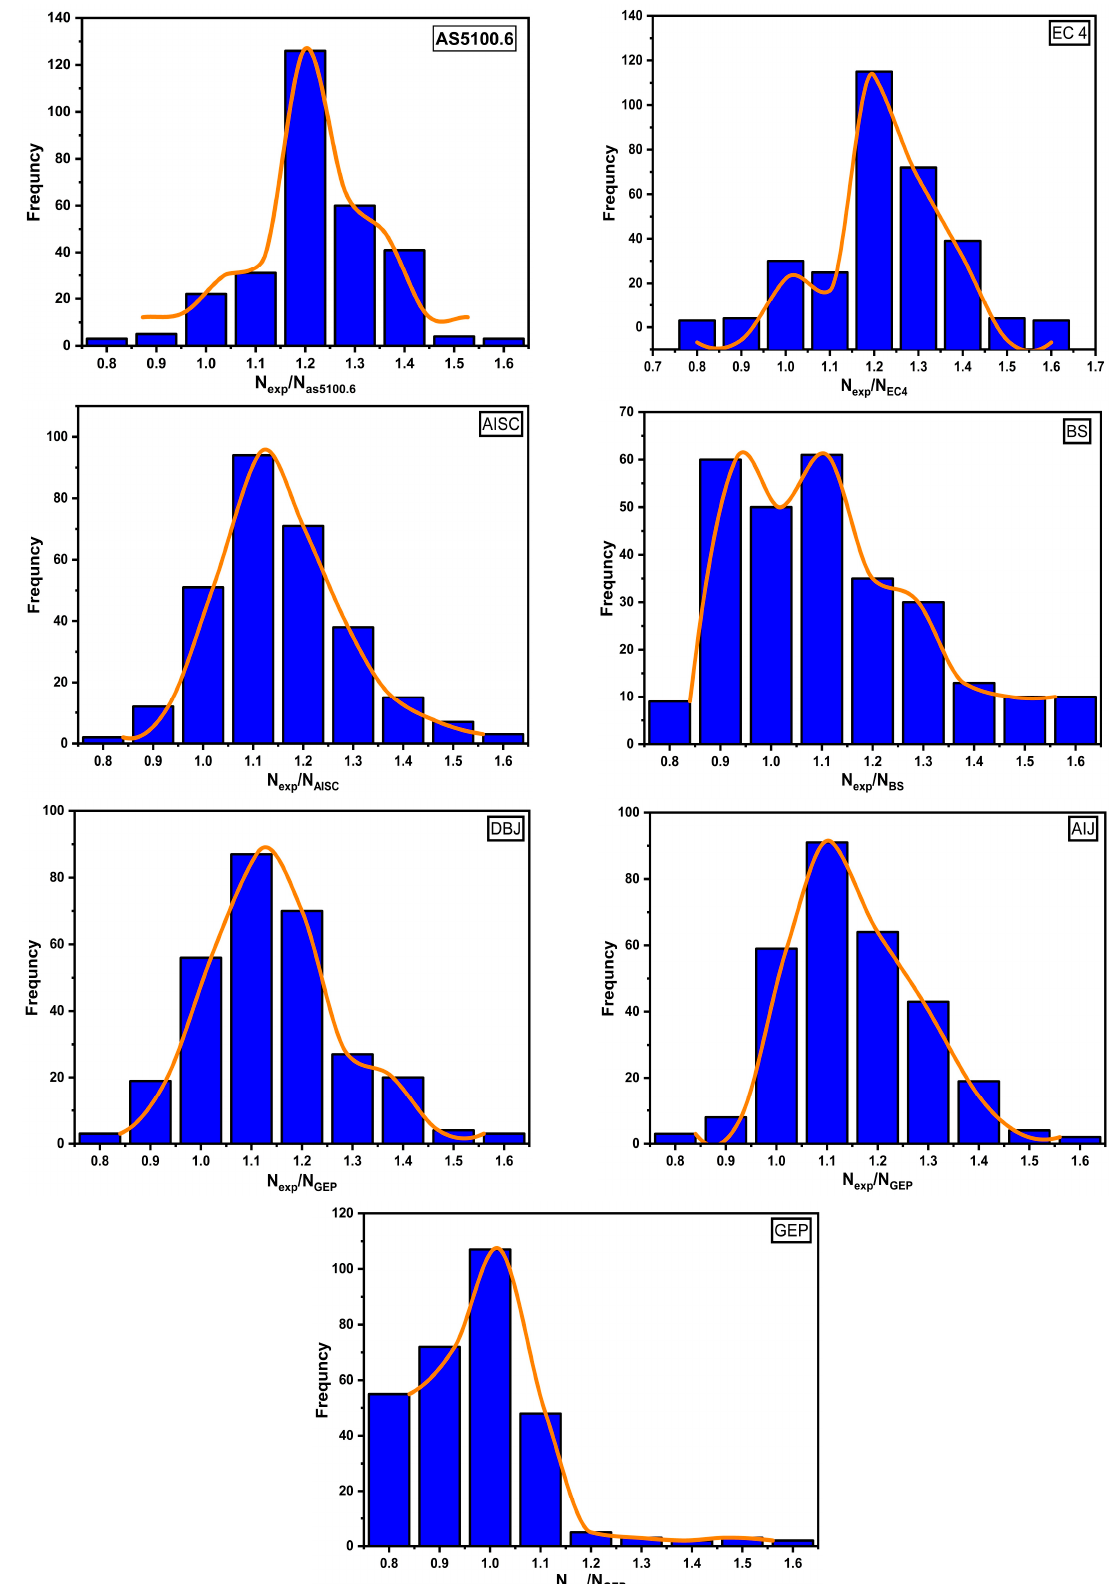
Figure 6. Evaluation of the concrete-filled steel tubes (CFST) columns experimental and predicted axial bearing capacity. Table 6. Axial strength prediction models overall performance.